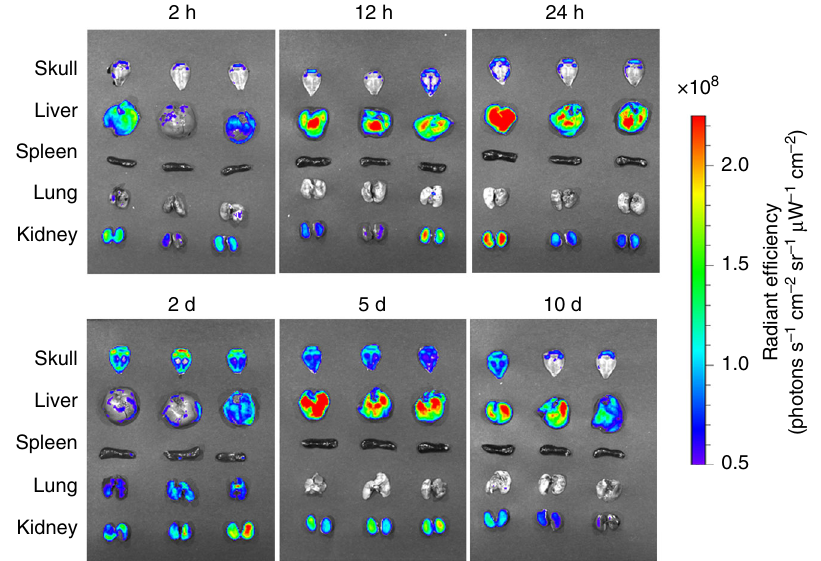
Fig. 5 In vivo bone-targeting ability of Apt-bioinspired MVs. Ex vivo fl uorescence images of isolated skull and main organs from mice injected with FITC- loaded Apt-bioinspired MVs over time. Source data of this fi gure are provided as a Source Data fi